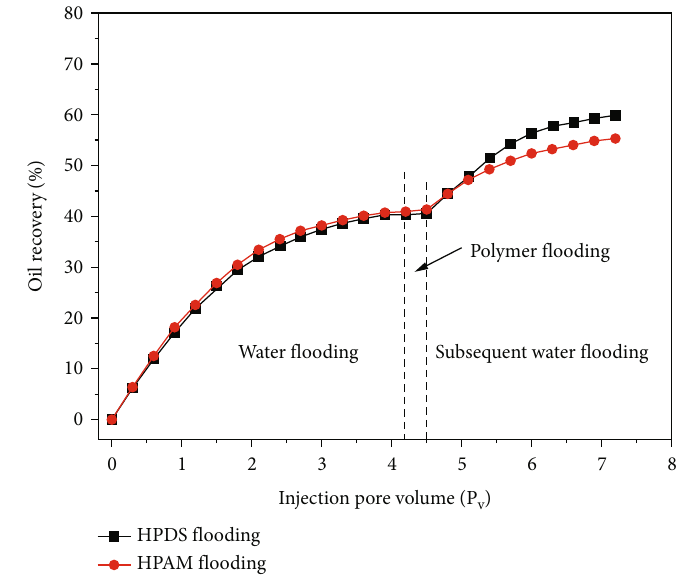
Figure 14: Relationship between oil recovery and injection pore